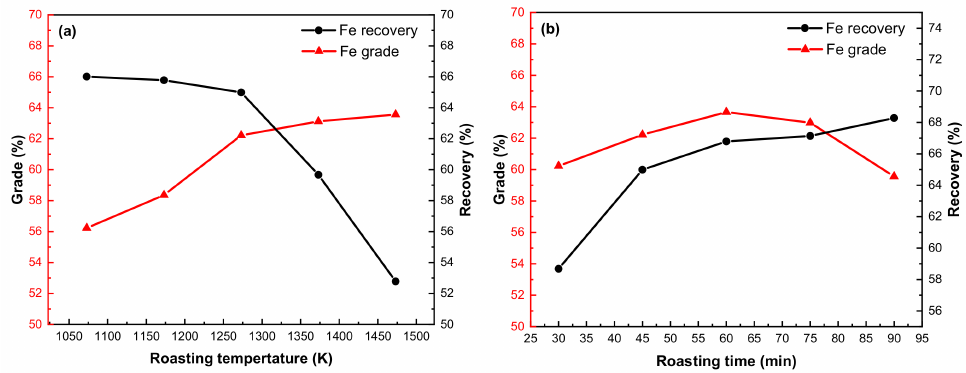
Figure 3. Effects of roasting temperature ( a ) and roasting time ( b ) on iron extraction.